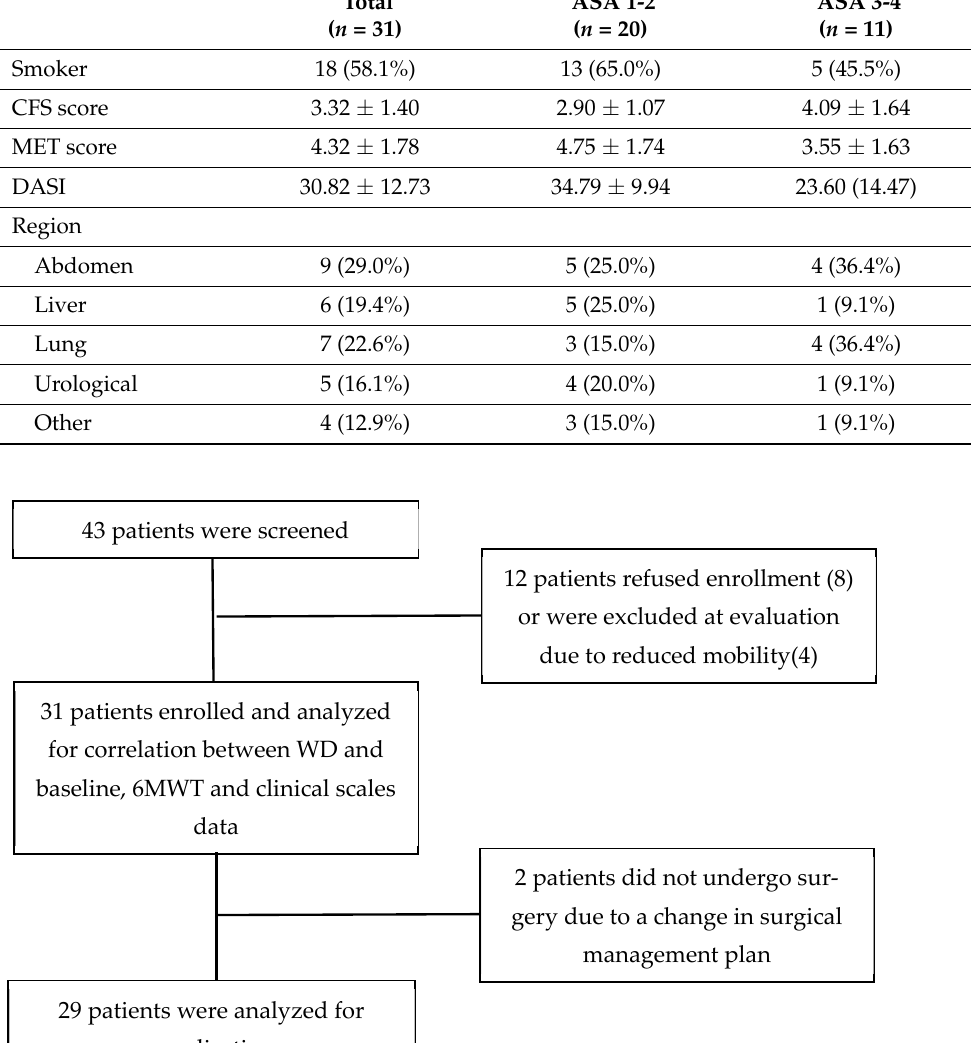
Figure 3. Relation of clinical evaluation scales to low–high performance 6MWT and to high–low average number of steps per day (above or below 10,000 steps per day on average). As evident from Figure 3, most patients that exceeded the 350 m threshold of the 6MWT also walked more than 10,000 steps per day on average, while only four of this group did not. When logarithmic transformation of the number of steps walked daily is applied, there was good correlation with the 6MWT performance (R = 0.56, p = 0.001). Correlation between the logarithmic transformation of daily step count and the 6MWT is reported in Figure 4. As depicted in this figure, the logarithm of the daily step count demonstrated good correlation with the 6MWT results (total walked distance), with r = 0.57 and p = 0.001.